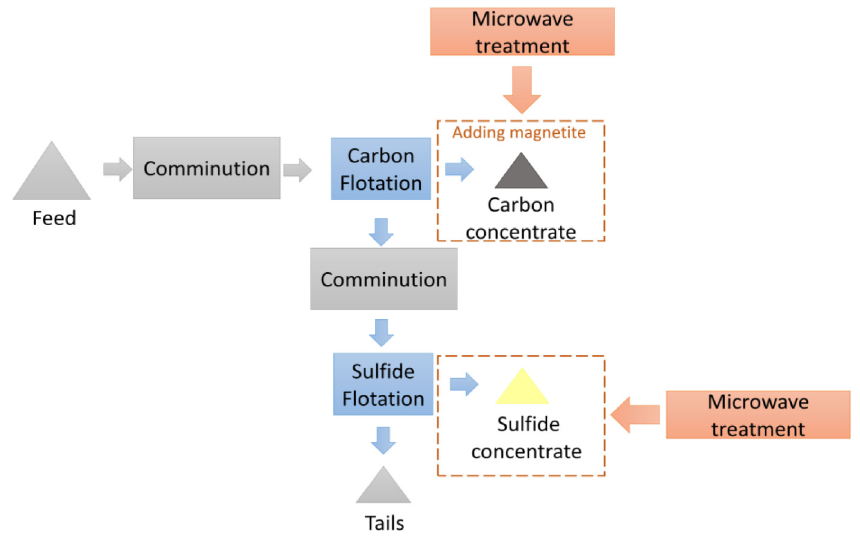
Figure 6. The scheme of the investigations into the application of microwave treatment.